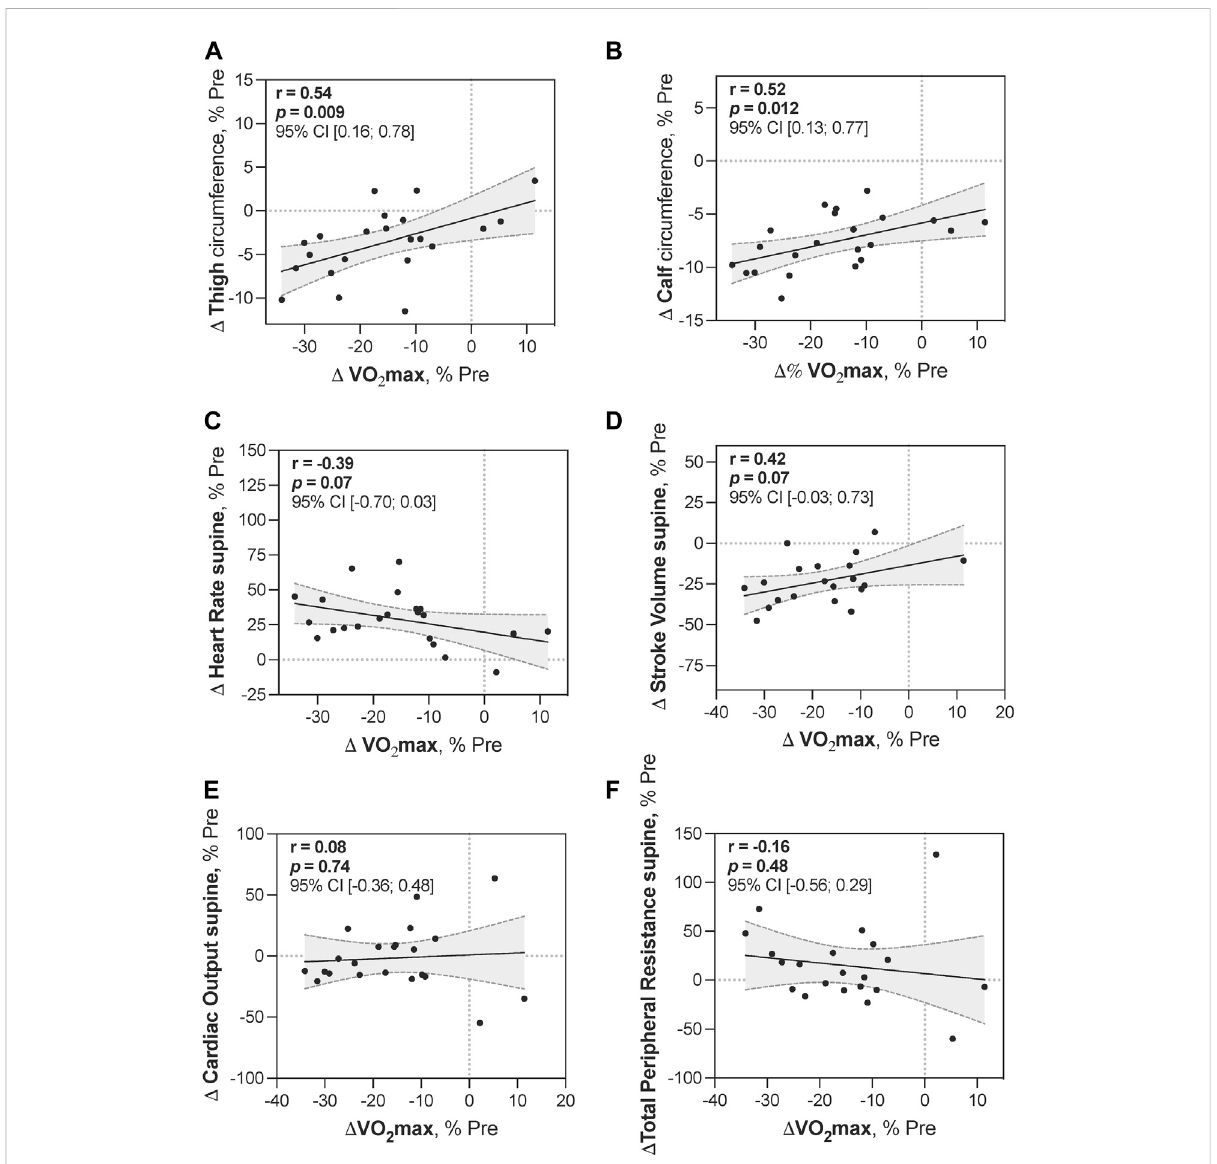
FIGURE 10 Correlations between changes in V _ O 2 max and muscular and cardiovascular variables. Correlations between relative changes in _ VO 2 max at R + 2andrelativedecreasesinthigh (A) andcalf (B) circumferencesatD84;relativechangesinsupineheartrate (C) ,strokevolume (D) ,cardiacoutput (E) , and total peripheral resistance (F) measured during the tilt test immediately after HDBR (R0). All groups are pooled